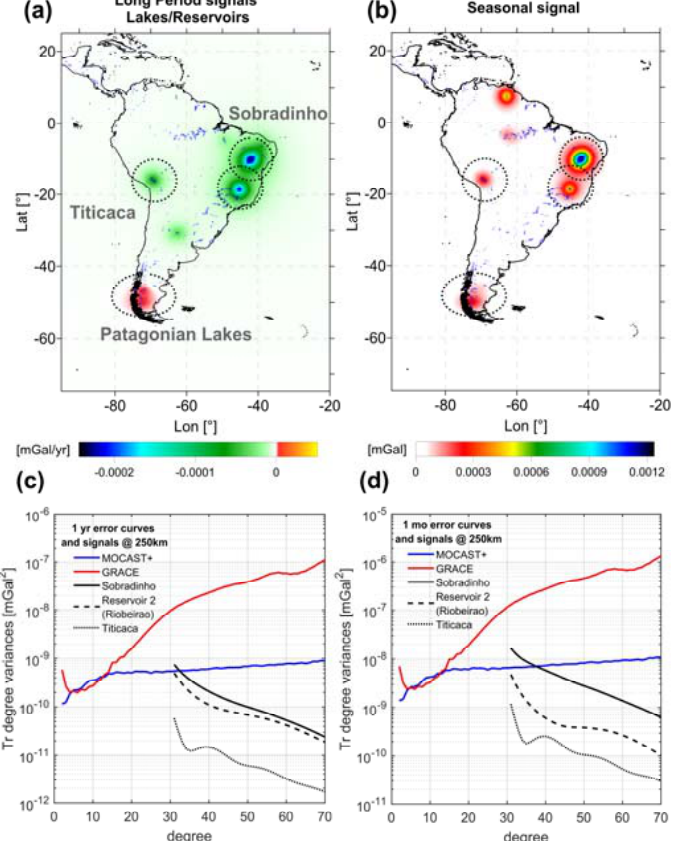
Figure 12. Gravity effects for a selection of South American Reservoirs/Lakes calculated at 250 km and their respective spectra: ( a ) Long-period trend gravity signals; ( b ) Yearly seasonal amplitude signals. The dashed outlines mark the various spherical caps considered. ( c ) Spectra of long-period yearly gravity rates for 3 South American lakes/reservoirs (black lines), 1-year error curves of MOCAST+ (blue) and GRACE (red). Rates expressed as the gravity change accumulated in one year. Spectra of fields calculated at 250 km altitude. ( d ) Spectra of seasonal amplitude for 3 Lakes/reservoirs in South America (black lines). Monthly error curves of MOCAST+ (blue) and GRACE (red). Spectra of fields calculated at 250 km altitude.